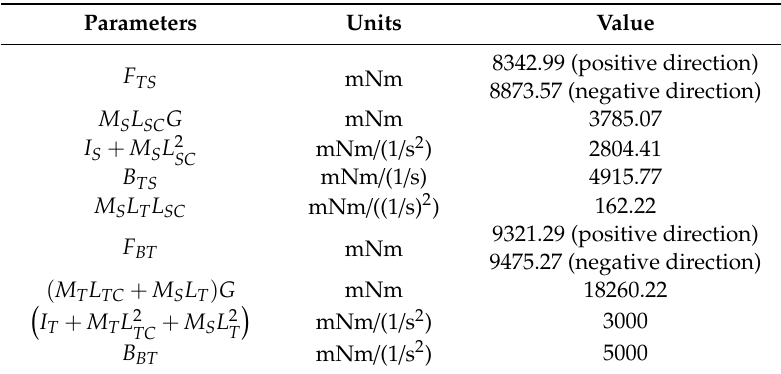
Table 1. Identified parameter values of the right